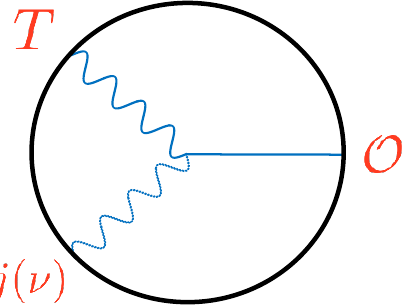
Figure 4 . CFT three-point functions h T O j ( (cid:23) ) i , computed holographically from AdS three-point diagrams like the one shown, are \extremal" when (cid:28) O = (cid:1) T + (cid:1)( (cid:23) ) + 2 n . When (cid:23) = (cid:0) ih and this becomes a h T T Oi correlator, these zeroes/poles at (cid:28)